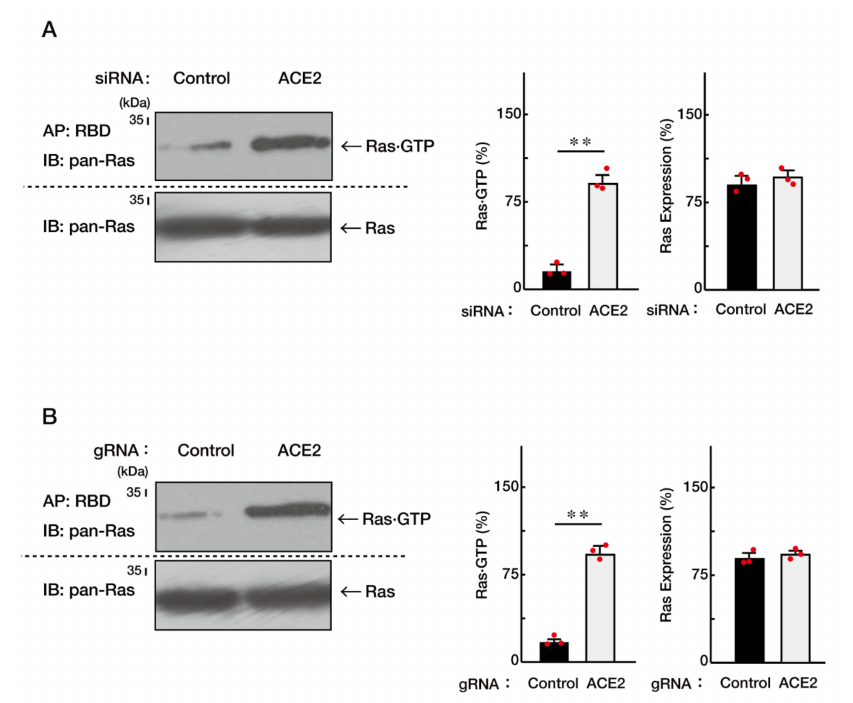
Figure 5. Knockdown of ACE2 promotes the GTP-bound form of Ras in affinity-precipitation assay. ( A ) The lysates of siRNA-knocked down FBD-102b cells were used for affinity-precipitation (AP) assay, monitoring activated GTP-bound Ras with Ras-binding domain (RBD). Total Ras proteins were also shown. Band intensities were also compared to be depicted in graphs (**, p < 0.01; n = 3 blots). ( B ) The lysates of gRNA-knocked down cells were used for affinity-precipitation assay to monitor active GTP-bound Ras. Total Ras proteins were also shown. Band intensities were also compared to be depicted in graphs (**, p < 0.01; n = 3